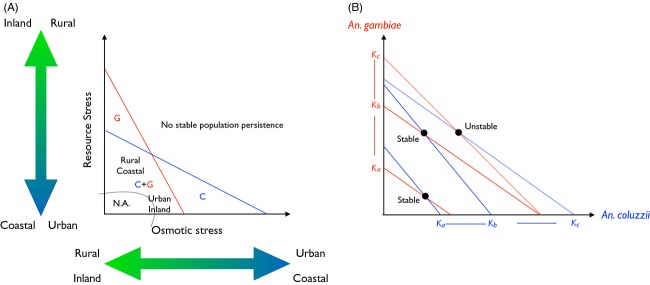
A theoretical framework of functional ecological interactions between An. gambiae and An. coluzzii in the forest ecozone of Central Africa. Panel (A) represents the zero isoclines of population growth in relation to different environmental stressors: blue (An. coluzzii) and red (An. gambiae) lines set the limits for combinations of osmotic and resource stress beyond which population growth becomes negative, leading to no stable persistence of either species. On the abscissa, osmotic stress is assumed to increase along the inland versus coastal, as well as the rural versus urban environmental gradients. On the ordinate, stress from lack of resources – particularly nutrients and suitable larval habitats – is supposed to increase in the reverse order along the same environmental gradients. The ‘N.A.’ region delimited in state space by a dotted curve is presumably not available in the study area (i.e. regions with abundant resources in presence of very low levels of osmotic stress). The ‘C’ and ‘G’ letters in state space define regions where An. coluzzii and An. gambiae, respectively, occur alone, whereas ‘C+G’ represents the region where both species can coexist. However, rural coastal areas have less resources and more variable osmotic stress than urban inland areas, accounting for their different location in state space and differences in carrying capacity Ki shown in panel (B). Panel (B) depicts graphically the outcome of competition generated by the classic Lotka–Volterra equations applied to the An. coluzzii versus An. gambiae species pair in the ‘C+G’ region of state space in panel (A). The axes refer to the population size of either An. coluzzii (blue) or An. gambiae (red). As carrying capacities increase moving from small rural to larger and larger urban habitats (Ka < Kb < Kc, direction of change indicated by arrows), the equilibrium point of joint population size changes from stable coexistence (cases a, b, continuous lines) to competitive exclusion (case c, dotted lines). For further discussion, see text.